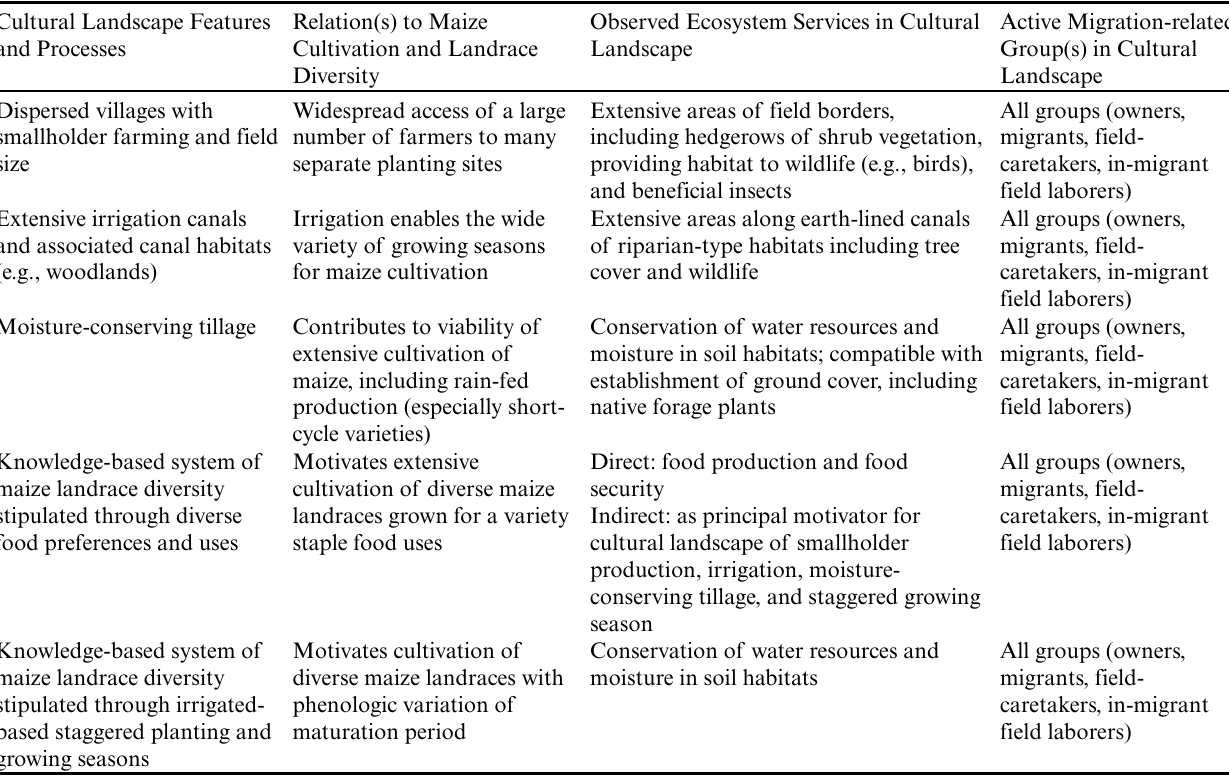
Table 2 . Features of cultural landscape supporting maize landrace diversity in Andean valleys: example of Tarata-Arbieto, Bolivia. Cultural Landscape